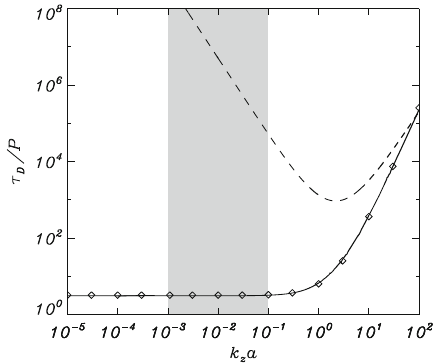
Fig. 69 Wave damping by Alfvén and slow resonances in an infinitely long prominence thread. Kink mode ratio of the damping time to the period, τ d / P , as a function of the dimensionless wavenumber, k z a , for l / a = 0 . 2. The solid line is the full numerical solution. The symbols and the dashed line are the results of the thin boundary approximation for the Alfvén and slow resonances, i.e., the two terms in Eq. (38). The shaded region represents the range of typically observed values for the wavelengths in prominence oscillations. Image reproduced with permission from Soler et al. (2009), copyright by